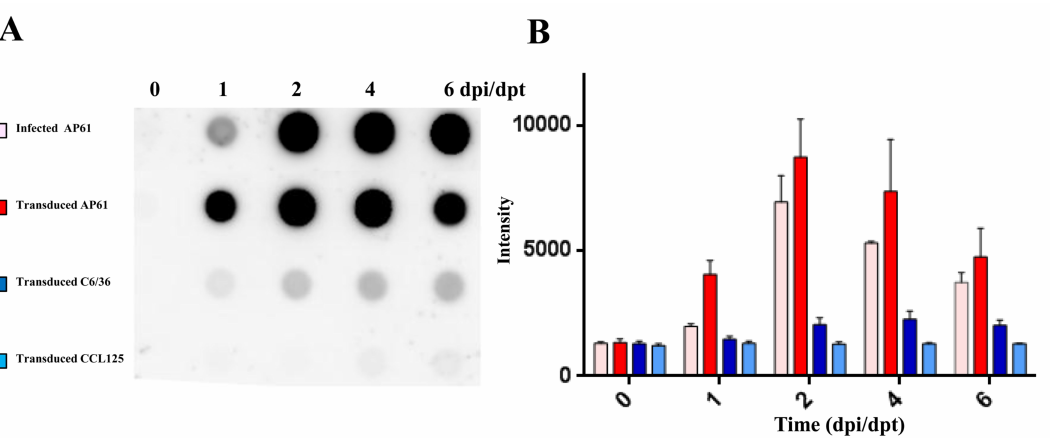
Figure 3. Results of dot blot analysis for the detection of secreted JEV viral glycoproteins. Three mosquito cell lines (C6 / 36, CCL-125, and AP-61) were transduced with BacMos-JEV-prME at an MOI of 2. C6 / 36 cells were infected with JEV at an MOI of 0.1. Culture medium was harvested at the indicated dpi and subjected to dot blot analysis ( A ) and quantification ( B